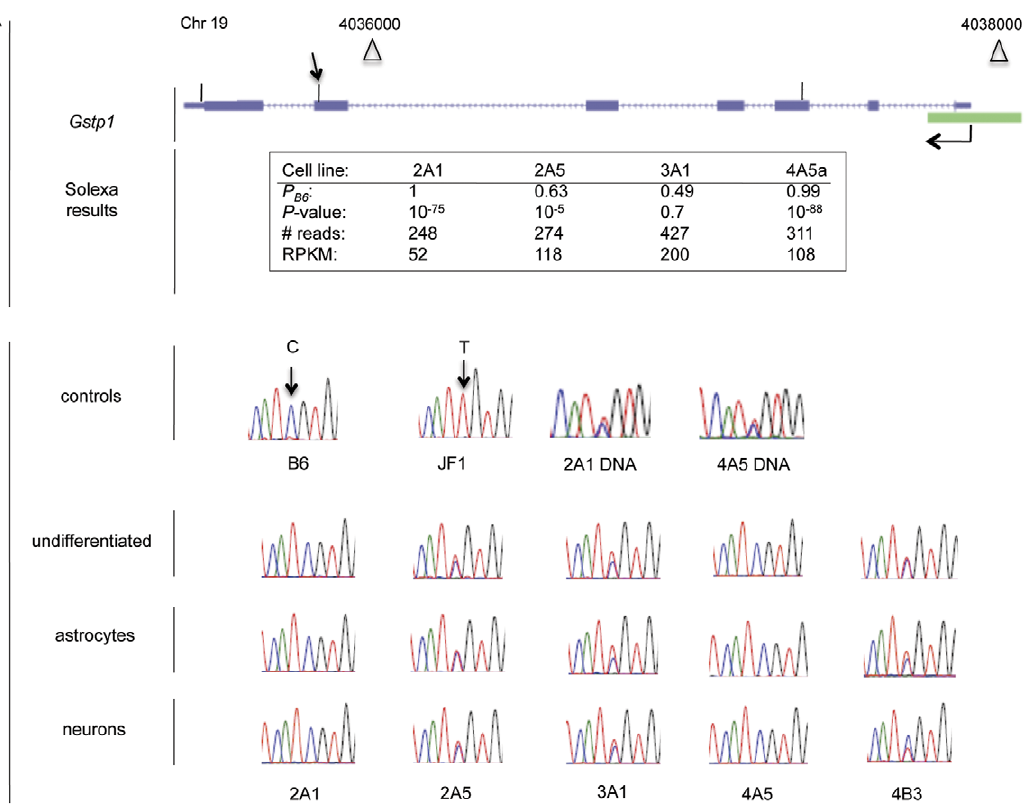
Figure 4. Allele-specific expression of Gstp1 . A. Structure of the gene and results of Illumina sequencing in four NSC lines. The chromosomal location, start site and orientation of transcription, the 7 exons, and a CpG island (green rectangle) at the 5 9 terminus are shown. The cSNPs in exons 3, 6 and 7 are indicated by the vertical lines above the respective exons. The table shows that the B6 allele is expressed in cell lines 2A1 and 4A5a, while both alleles are expressed in cell lines 2A5 and 3A1. B. RT-PCR results. First row: Chromatograms show a C/T cSNP between B6 and JF1 transcripts, and the presence of both alleles in genomic DNA of NSC lines 2A1 and 4A5. The arrow in Figure 4A indicates the location of the cSNP. Second to fourth rows: Analysis of RNA isolated from five NSC lines in the undifferentiated state, and differentiated to astrocytes and neurons, as indicated. The B6 allele is expressed in cell lines 2A1 and 4A5, while both alleles are expressed in cell lines. 2A5, 3A1 and 4B3. doi:10.1371/journal.pone.0031751.g004 Table 2. Selected list of autosomal genes with monoallelic expression by Illumina sequencing validated by RT-PCR.